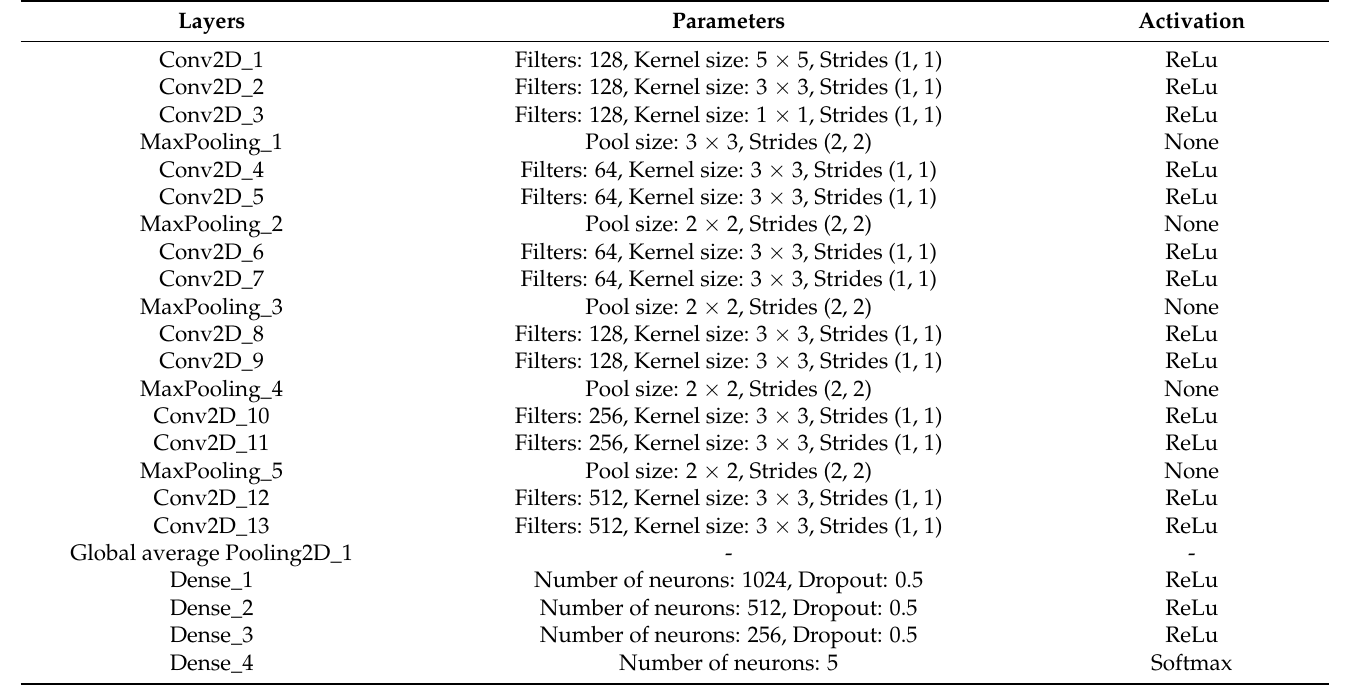
Table 2. Structural parameters of convolutional neural